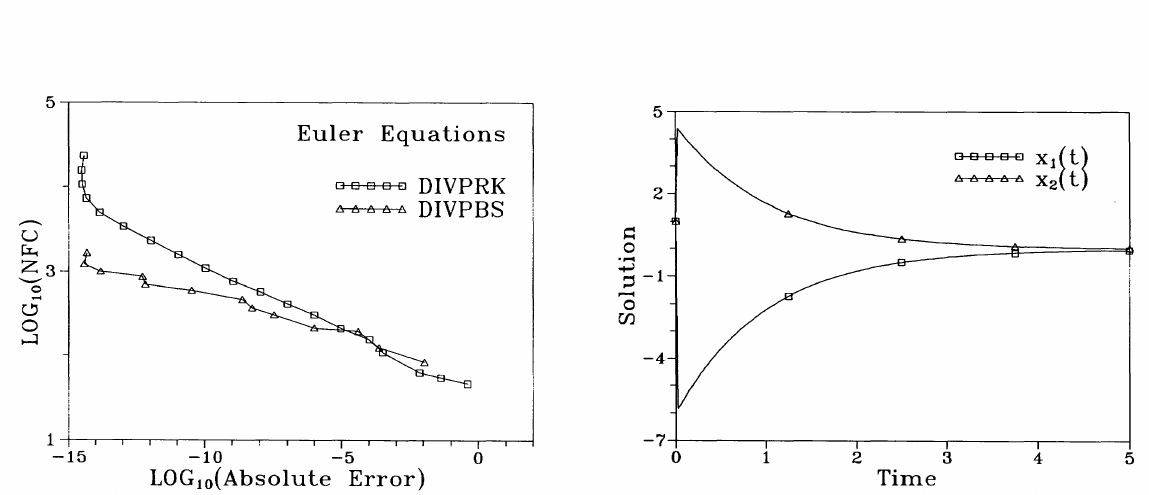
FIGURE 23 Solution of example 5 for the gradual change